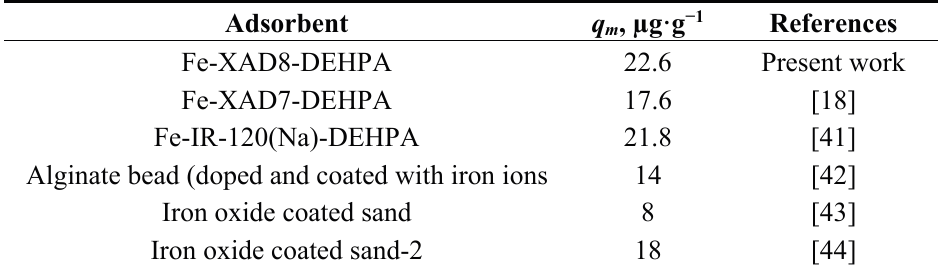
Table 3. Maximum adsorption capacities develop by various adsorbent loaded with iron ions in the removal process of arsenic from water.